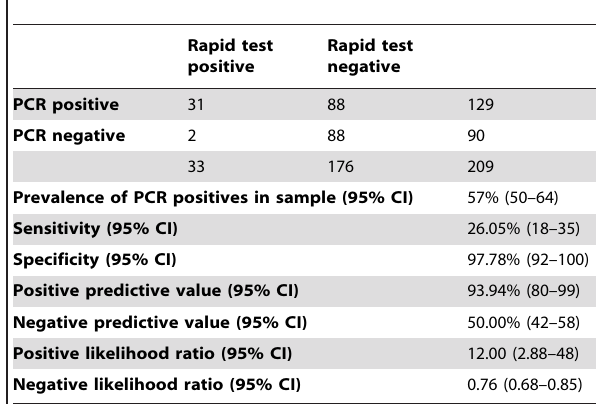
Table 1. Performance of the QuickVue Influenza A + B rapid test in comparison with RT-PCR in the diagnosis of pandemic H1N1 (2009) virus infection.